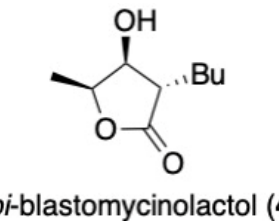
Figure 6. The structure of epi-blastmycinolactol ( 45 ) [84] .